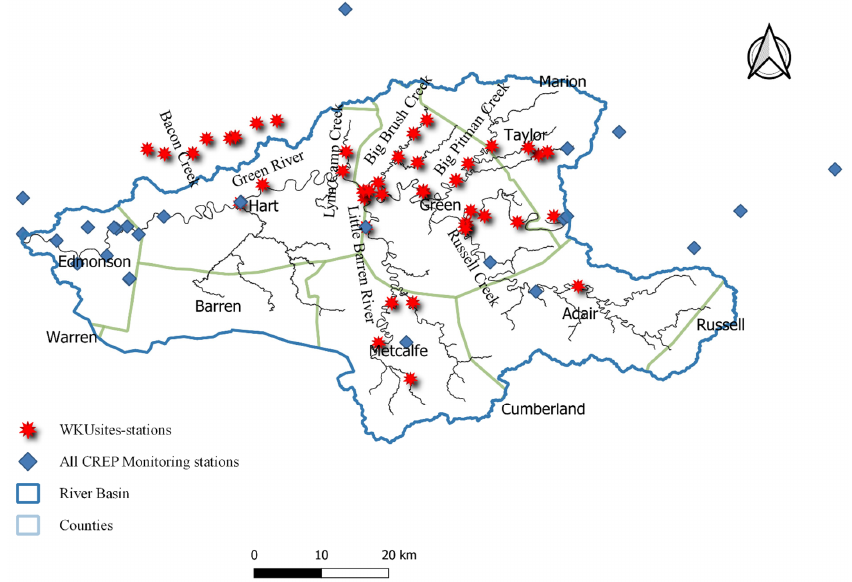
Figure 1. The stream networkand the sampling stations in the Upper Green River watershed.